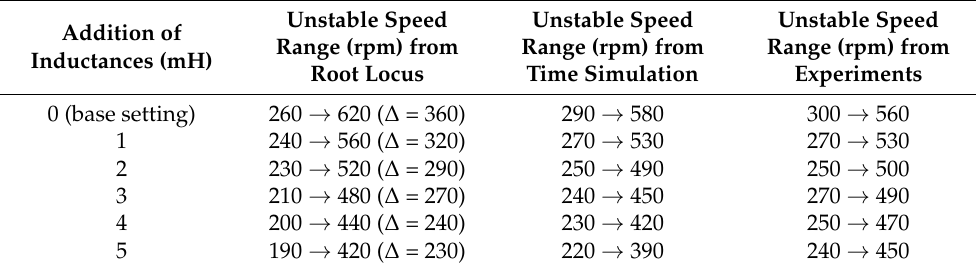
Table 3. Results of the different means of study for different series inductances